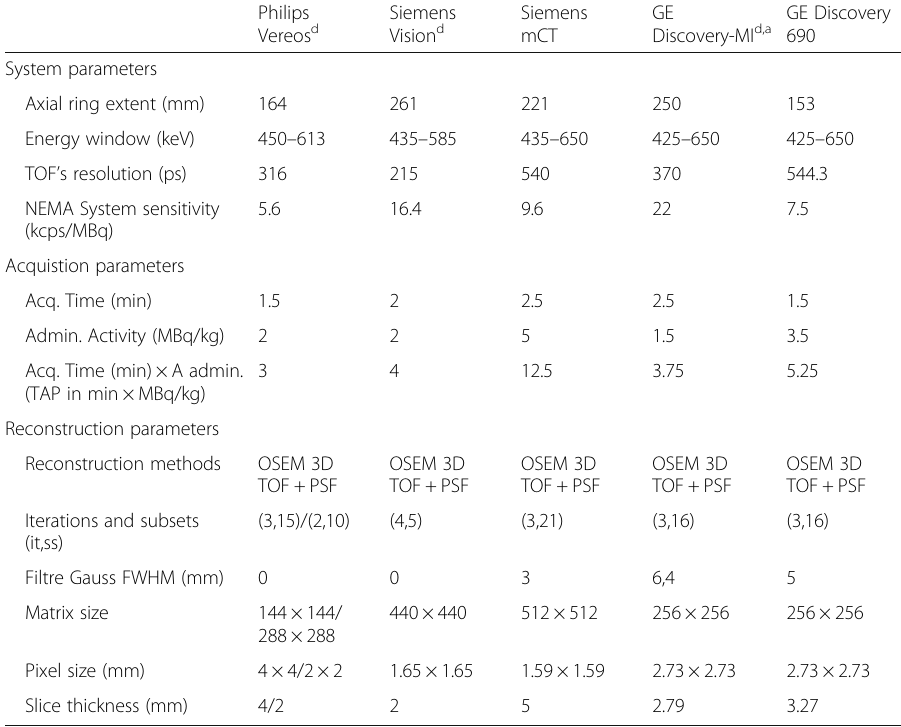
Table 1 Systems, acquisition and reconstruction parameters applied in clinical whole-body oncologic 18 F-FDG PET